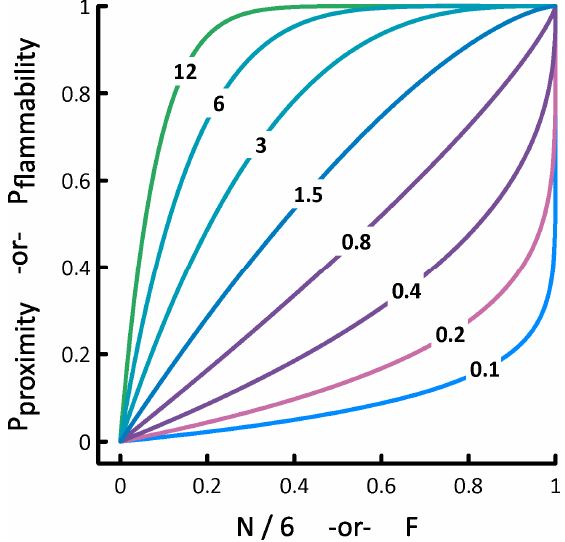
Figure 1. Shapes of the probability curves derived from specific values of N (neighbors on fire) or F (relative flammability), and α or β (the proximity and flammability exponents). Exponent values are superimposed on the curves they produce.